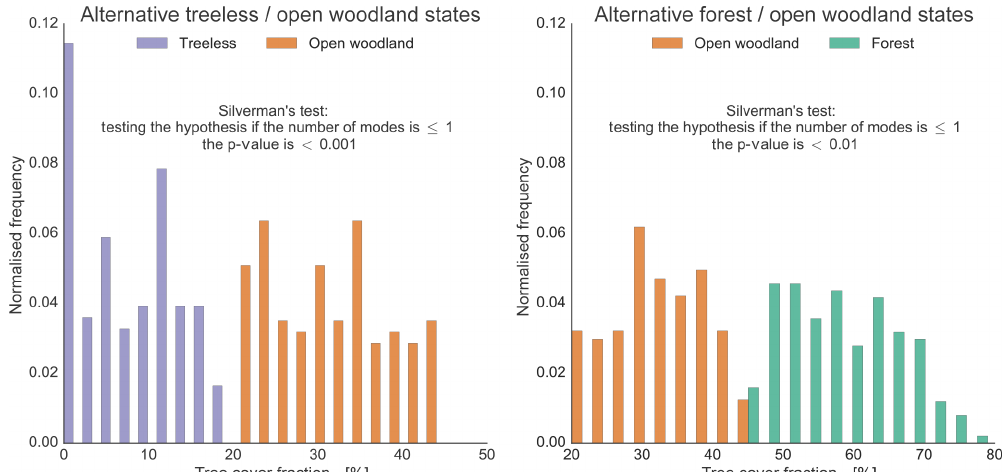
Figure 4. Tree-cover fraction distribution over the grid cells where equivalent or fire-disturbed open woodland and treeless states are found (left), and where equivalent or fire-disturbed open woodland and forest states are found (right). For each case the Silverman’s test verifies the hypothesis that the distribution is unimodal. The p value is low in both cases, confirming the multimodality of the